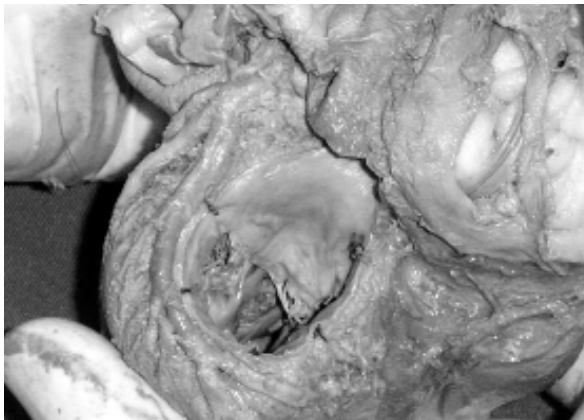
Fig. 2 - Peça anatômica com circulação balanceada. Relação anatômica entre as estruturas em estudo.